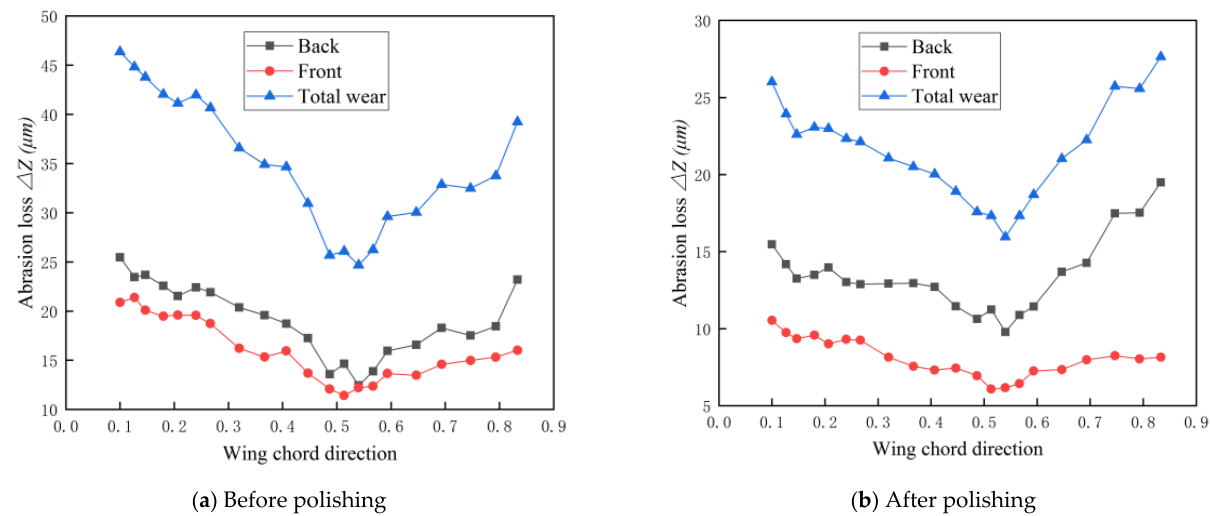
Figure 22. ( a , b ) Wear on the chord of different airfoil types ( P = 30.9 MW).